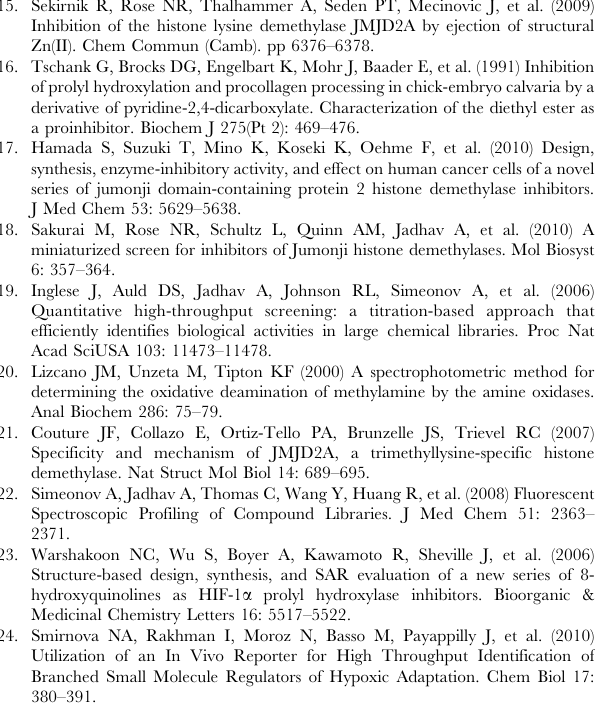
Figure S1 HTS statistical performance. A robust Z 9 factor was maintained throughout the HTS for JMJD2E inhibitors. Figure S2 Kinetics and Mode of Inhibition of 5-carboxy- 8-8HQ against JMJD2E. FDH assay was carried out at 2 m M JMJD2E, 200 m M ARK(me3)STGGK peptide (excess of Km) and varying 2OG concentrations.